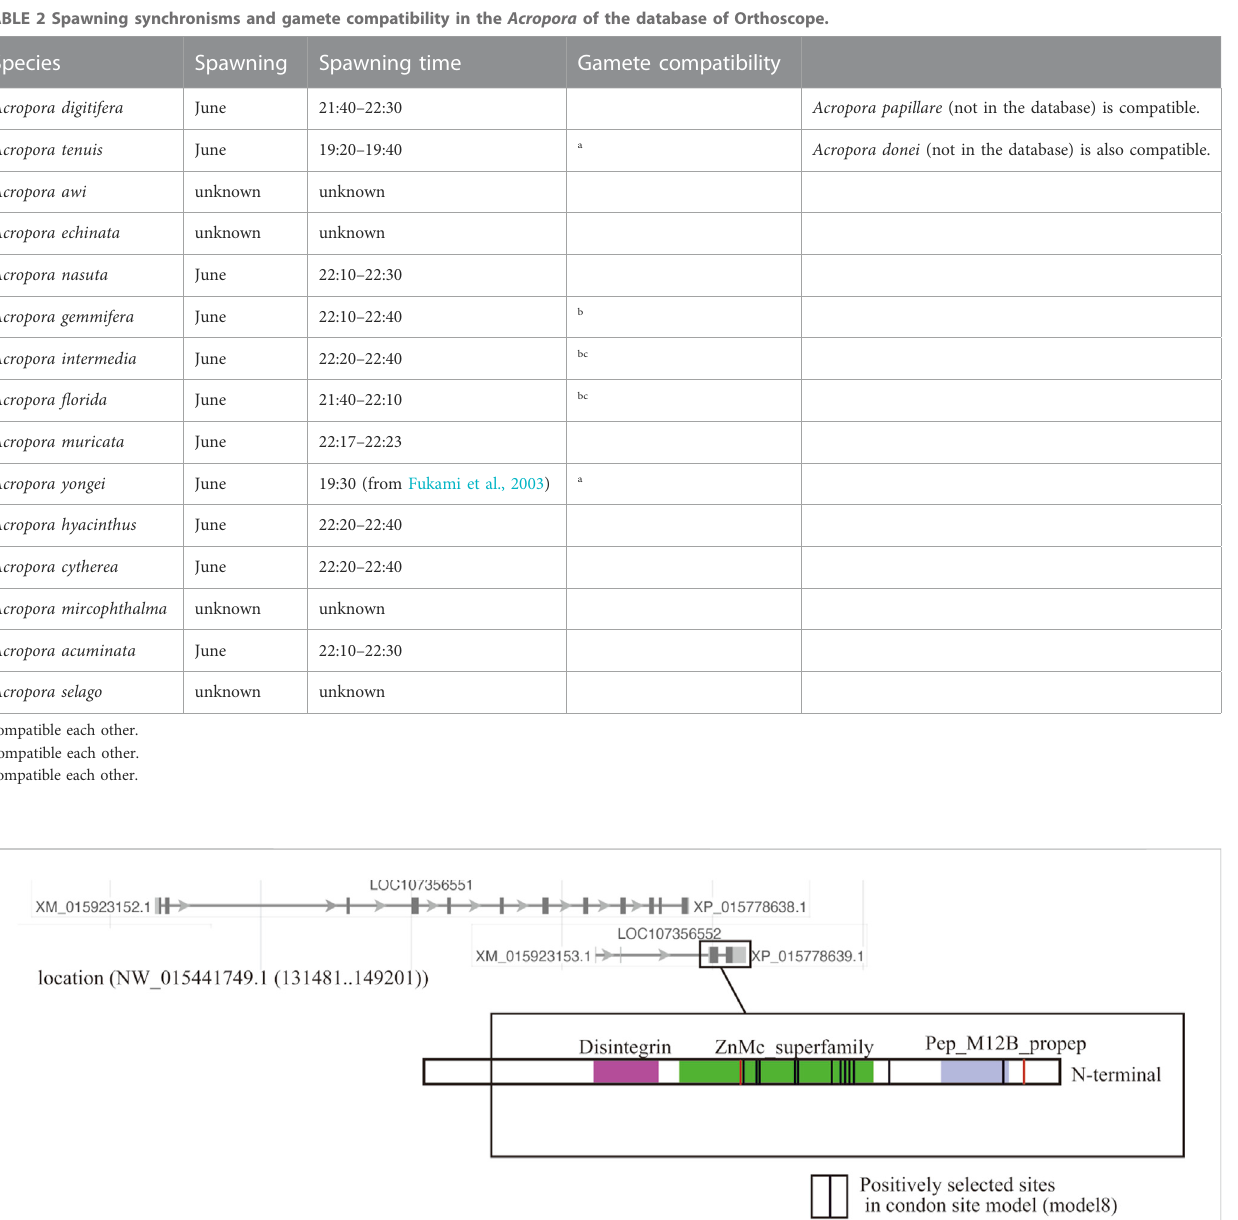
polyclonal antibody. Antibody preparation was conducted at Biologica Co. (Nagoya, Japan). Antiserum was puri fi ed with Protein A, and IgG was eluted with 0.1 M glycine (pH 3.0). The